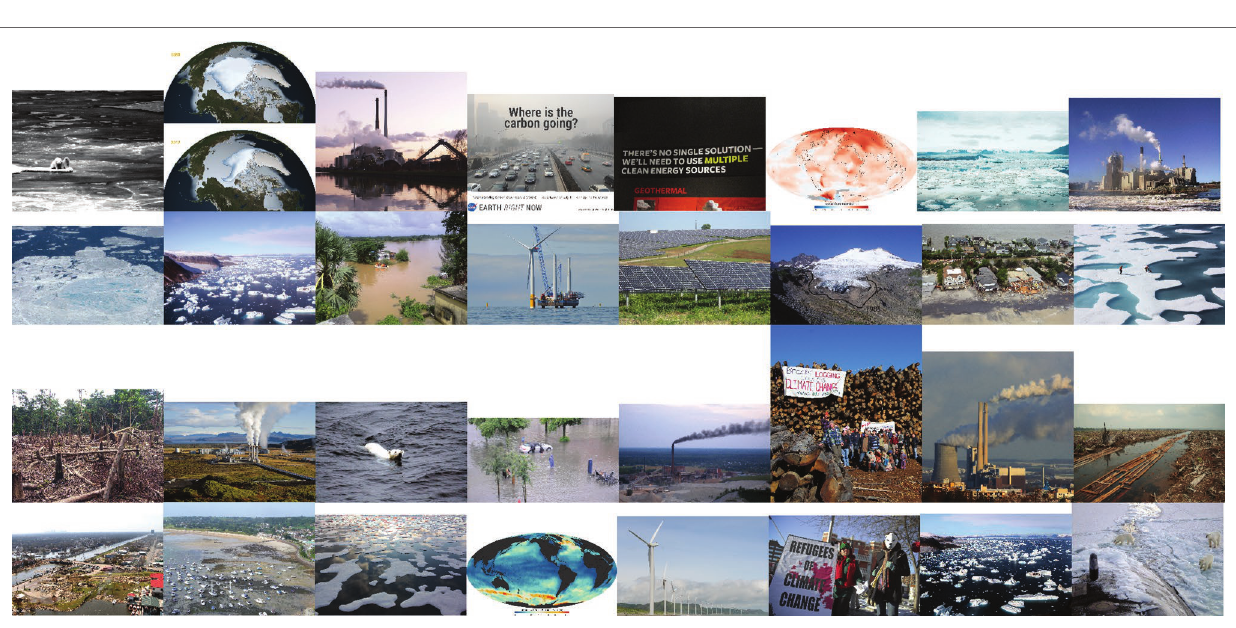
There were no significant correlations between environmental beliefs and arousal scores, r (60) = 0.001, p = 0.994, or valence scores, r (60) = −0.174, p = 0.175, for the most relevant images.